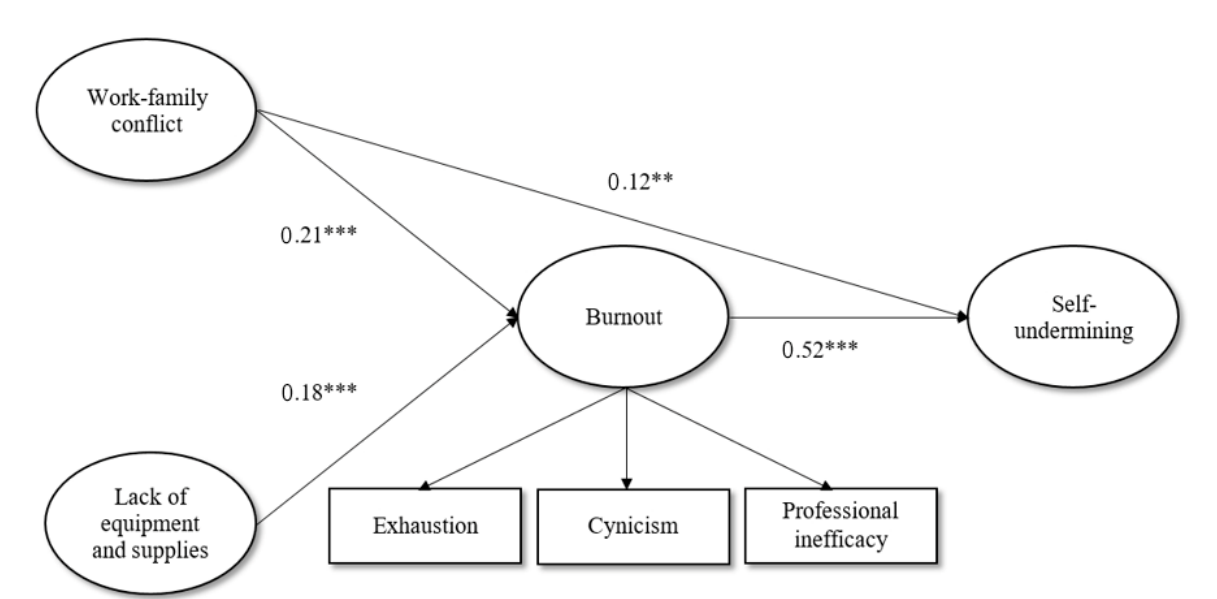
Figure 1. Standardized estimates for the relationships between job demands, burnout, and self-undermining. Note: ** p < 0.01; *** p < 0.001.